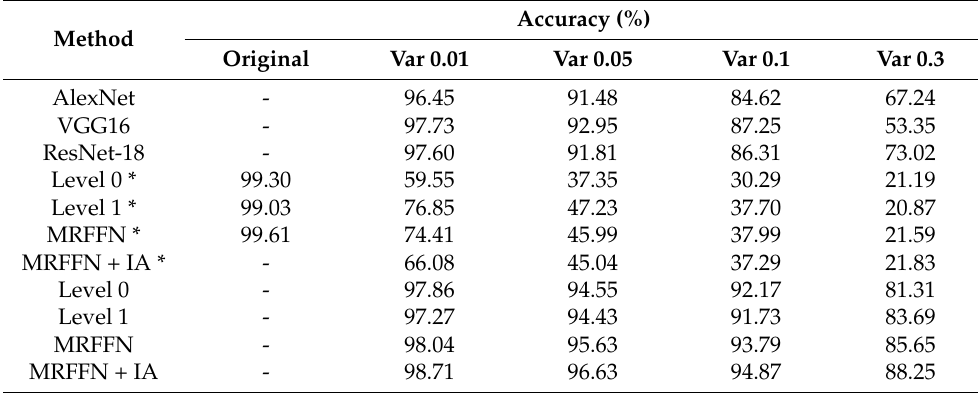
Table 4. The performance of the proposed method on Gaussian white noise.